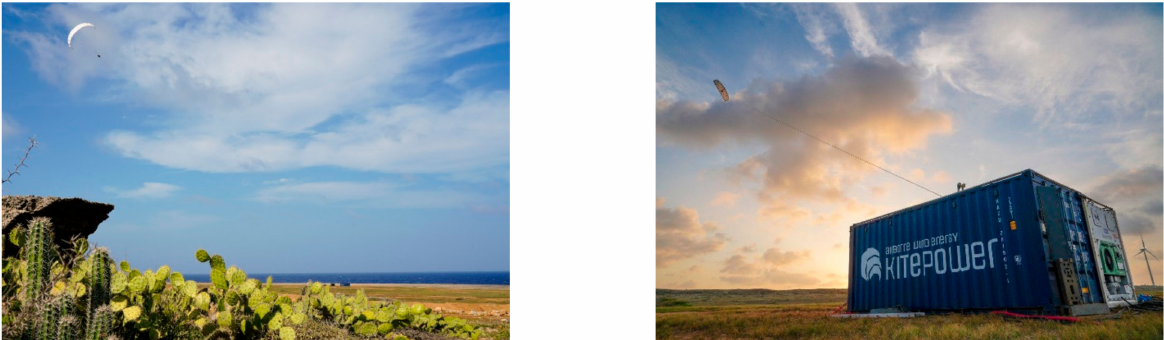
Figure 2. Pilot operation of the 100 kW AWE system of Kitepower on the Caribbean island Aruba in October 2021 (photo courtesy of Kitepower B.V.).